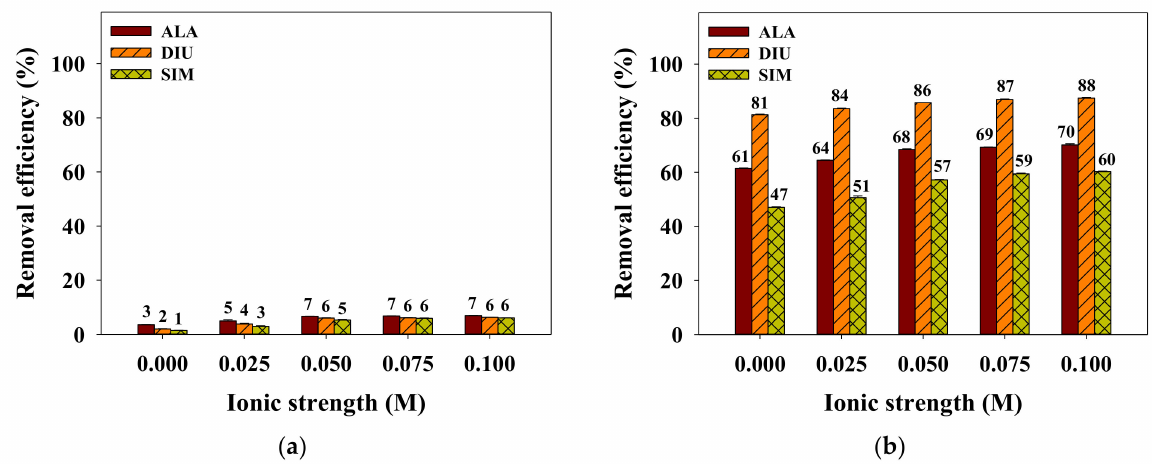
Figure 9. The effects of ionic strength on the removal of the herbicides by ( a ) the GCRB and ( b ) GCRB-N (agitation speed = 150 rpm, contact period = 24 h, absorbent dosage = 50 mg/L, initial concentration of each herbicide = 10 µ M, pH 7, and temperature = 25